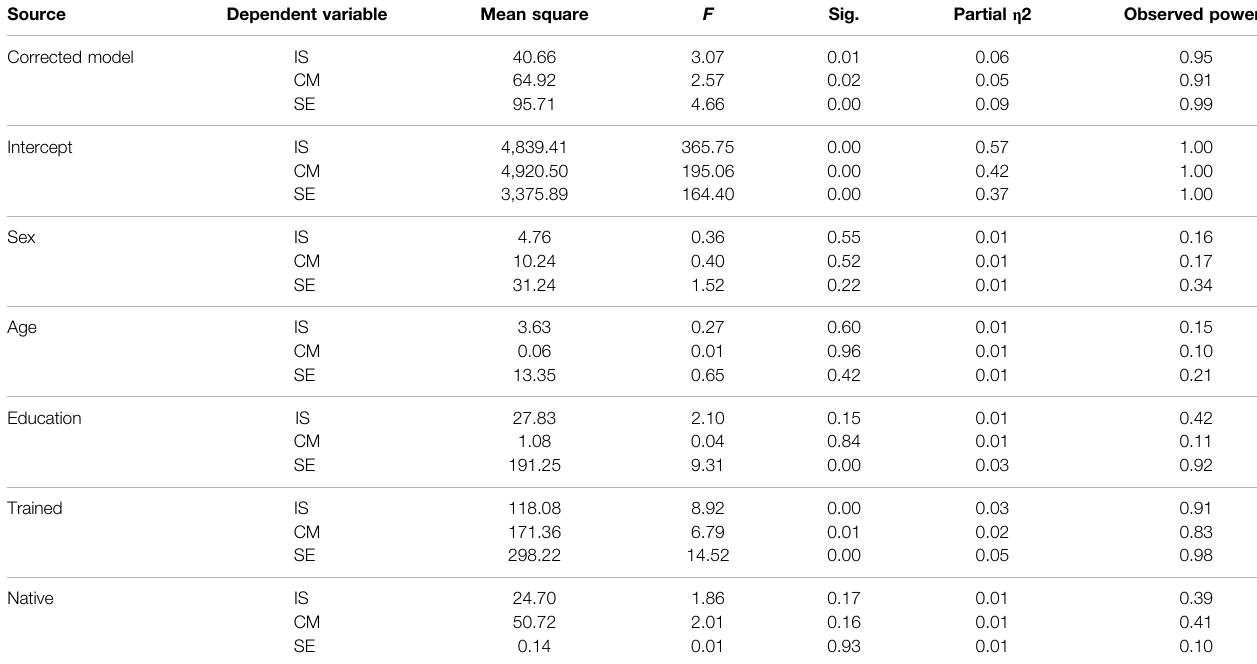
TABLE 6 | Tests of between-subjects effects.